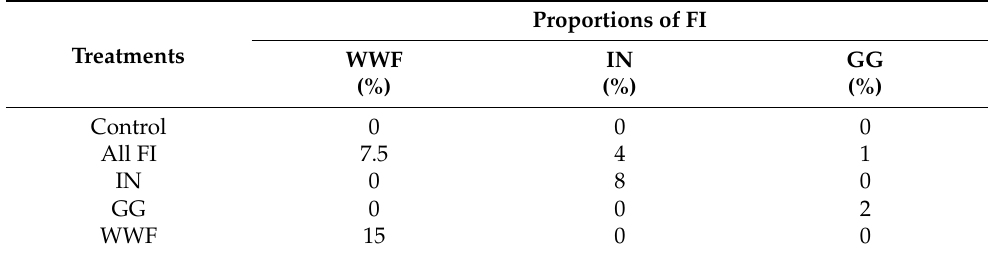
Table 1. The proportion of functional ingredients supplemented into Pita and Tandoori breads [8]. Proportions of FI Treatments WWF IN GG (%) (%) (%) Control 0 0 0 All FI 7.5 4 1 IN 0 8 0 GG 0 0 2 WWF 15 0 0